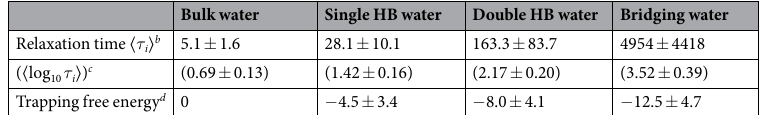
Table 2. Average relaxation time and trapping free energy a . a Average ± standard deviation; b Relaxation time in ps computed with individual relaxation times τ i ; c Statistics computed with log 10 τ i ; d Trapping free energy in kcal/